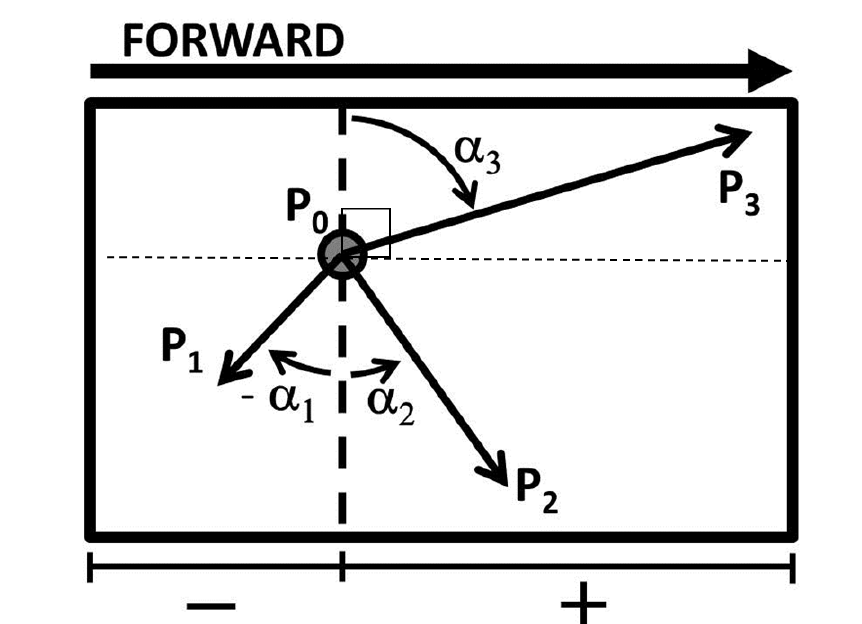
Figure 1. Examples of three situations for the α angle. P indicating the direction of the ball after the player passes